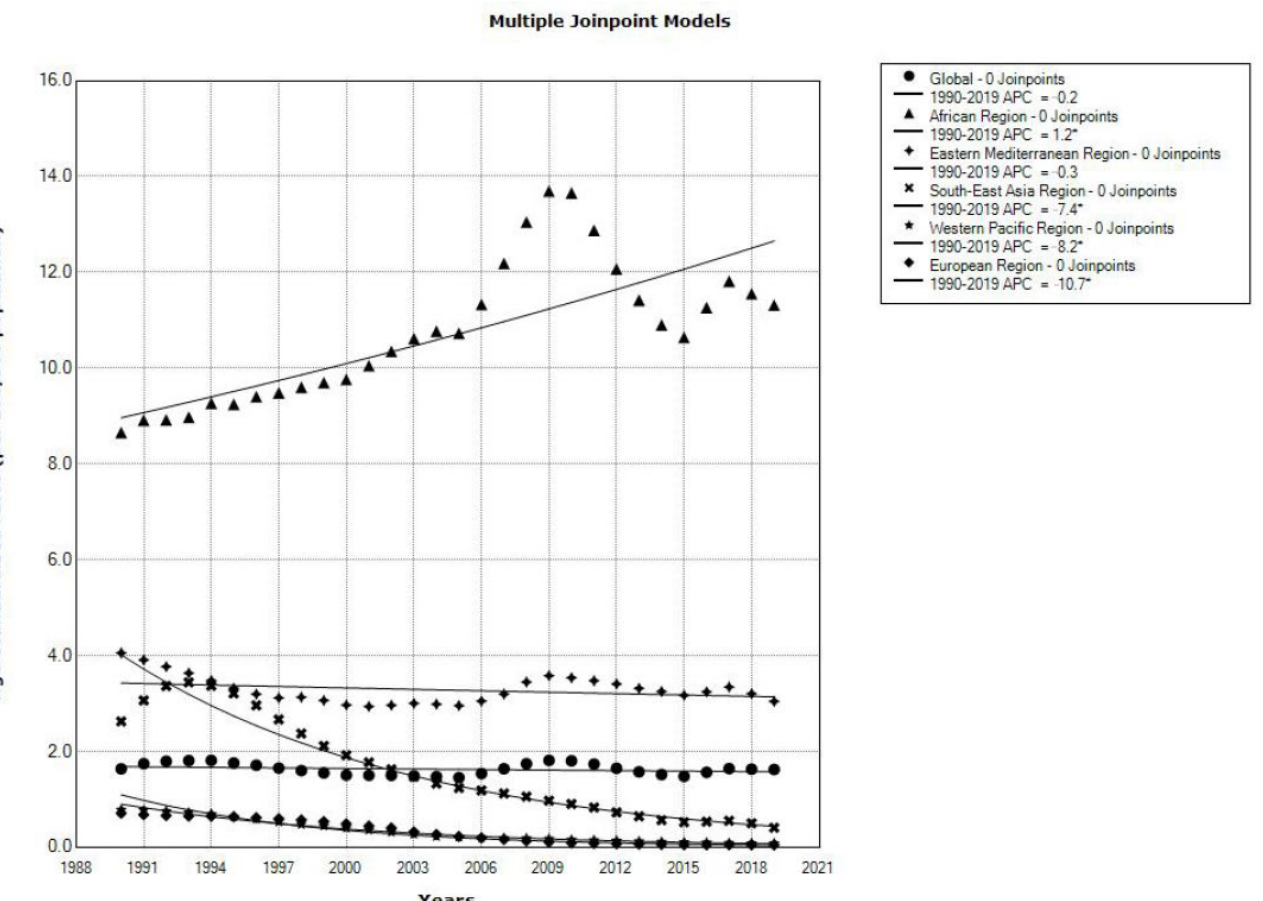
Figure 5. Joinpoint regression analysis of cholera mortality (global and by regions of World Health Organization), 1990–2019. * Statistically significant trend ( p < 0.05). (Source of data Ref. [10]). Globally, cholera-related mortality significantly decreased in males (by − 0.4% per year, 95% CI = − 0.7 to − 0.1), while a stable trend was observed in females (by − 0.1% per year, 95% CI = − 0.4 to 0.2) in the observed period (Figures 6 and 7). Joinpoint analyses of mortality both in males and females identified five joinpoints in the years 1993, 2000, 2005, 2009, and 2014, with six trends. The first, fourth, and sixth periods in males showed significantly increasing trends, with APC of 3.8%, 5.9%, and 1.5%, respectively (Figure 6). In males, the trends from 1993 to 2000 and from 2009 to 2014 showed a significant decrease (with APC of − 2.9% and − 4.3%, respectively). The first, fourth, and sixth periods in females showed significantly increasing trends, with APC of 3.8%, 6.2%, and 1.9%, respectively. In females, the trends from 1993 to 2000 and from 2009 to 2014 showed a significant decrease (with APC of − 2.8% and − 3.7%, respectively). In both males and females, cholera-related mortality trends from 2000 to 2005 were stable, with APC of − 0.9% and − 0.7%, respectively. According to the comparability test, the trends in cholera-related mortality in males and females were not parallel and not coincident ( p <